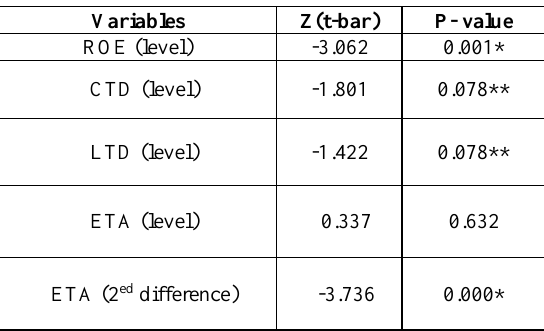
Table 2: Pesaran s CADF Test